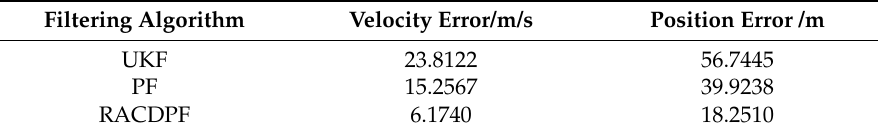
Table 5. The error statistics of the three filtering algorithms ( M = 50).